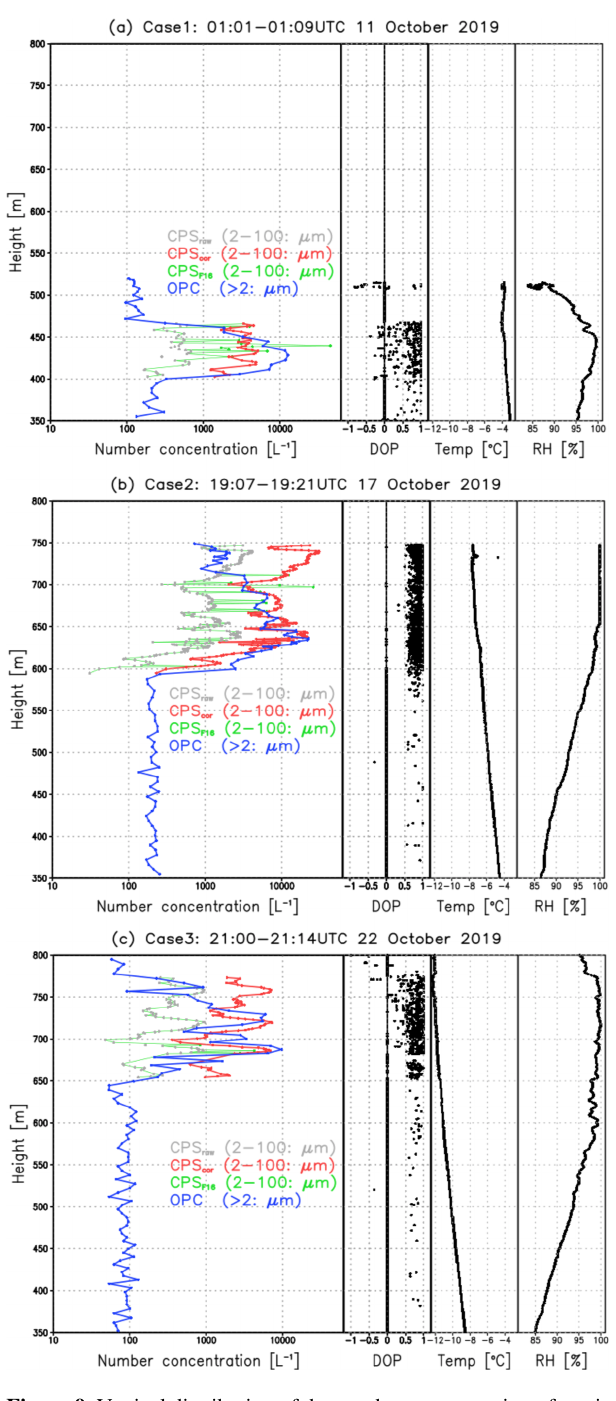
Figure 9. Vertical distribution of the number concentration of parti- cles larger than 2µm by the OPC (blue) and CPS sonde (corrected in this study in red; corrected by Fujiwara et al., 2016, in green) during the tethered balloon measurements on RV Mirai . Gray dots indicate the original CPS total counts. The values of DOP, air temperature, and relative humidity are indicated by black dots and black lines for each